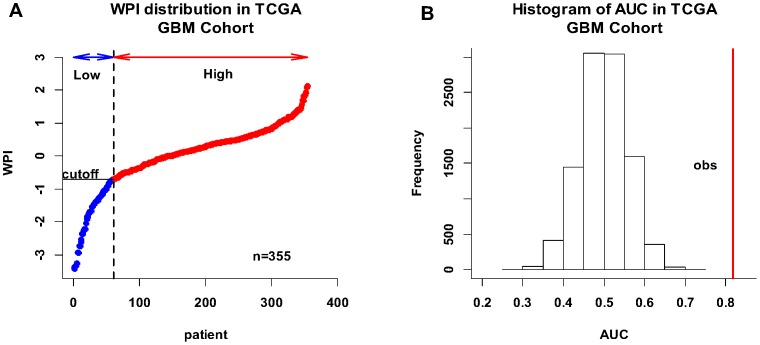
WPI distribution and AUC histogram of the TCGA GBM cohort.A, WPI distribution in the TCGA GBM cohort (n = 355). The point at which the distribution changed the most abruptly, which corresponded to (WPI = −0.7), served as the distribution cutoff. Patients were categorized as high risk (n = 294, left double-headed arrow) or low risk (n = 61, right double-headed arrow). B, Histogram of the empirical distribution of AUC generated from 10,000 permutations. The vertical dashed line is the observed AUC in the TCGA GBM cohort.